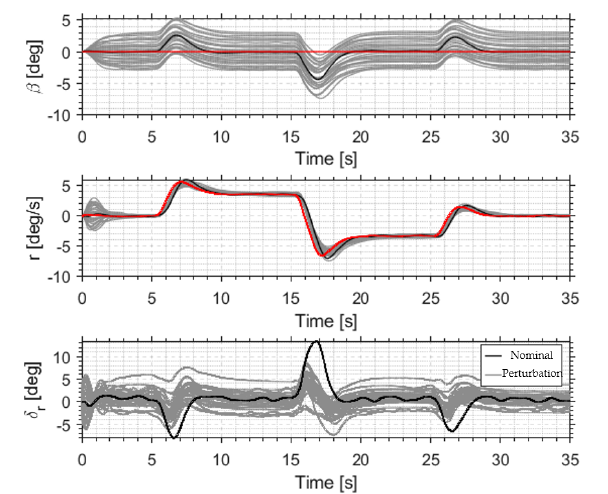
Figure 19. Perturbation simulation of the directional channel at 1 km altitude and 0.2 Mach number.